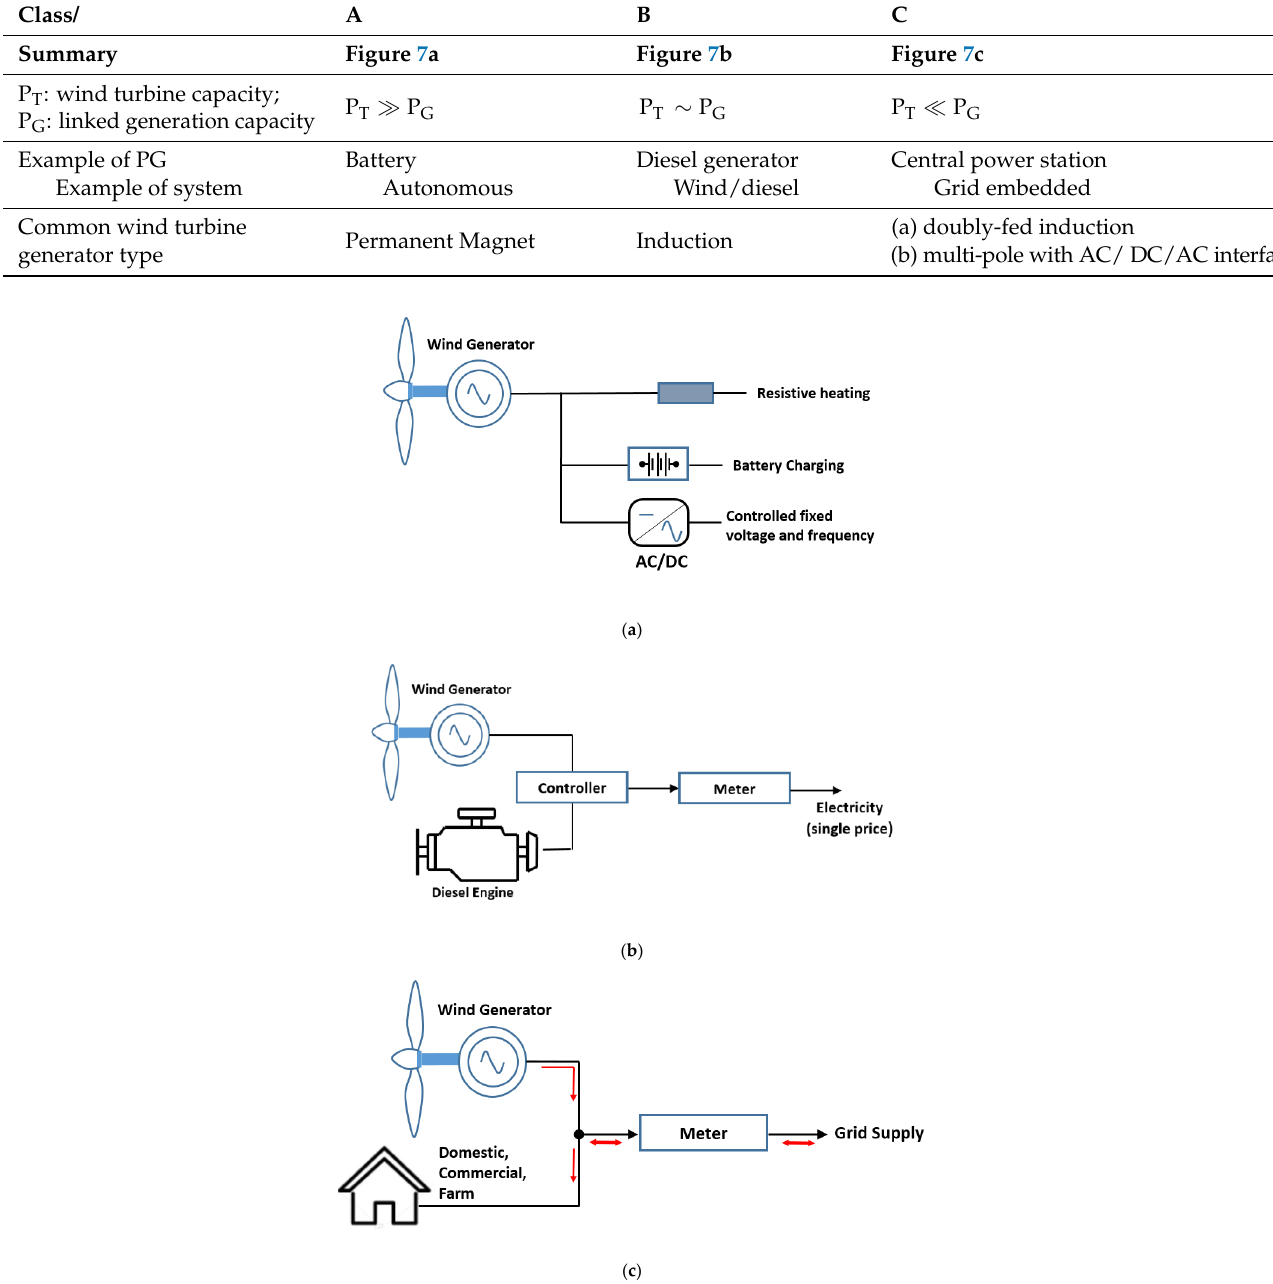
Figure 7. Wind turbine electricity system classification examples. ( a ) Class A: Stand-alone small-wind energy system with the wind turbine as the dominant supply (high-quality electricity via ‘piggy-backing’ on a dominant supply of less quality); ( b ) Class B: Wind/battery supply mode: single mode (using all wind-generated power in windy conditions and as the wind speed decreases, the cheaper serviced loads are automatically switched off to decrease the demand); ( c ) Class C: Small-wind energy system grid-linked wind turbine slaved in a large system.